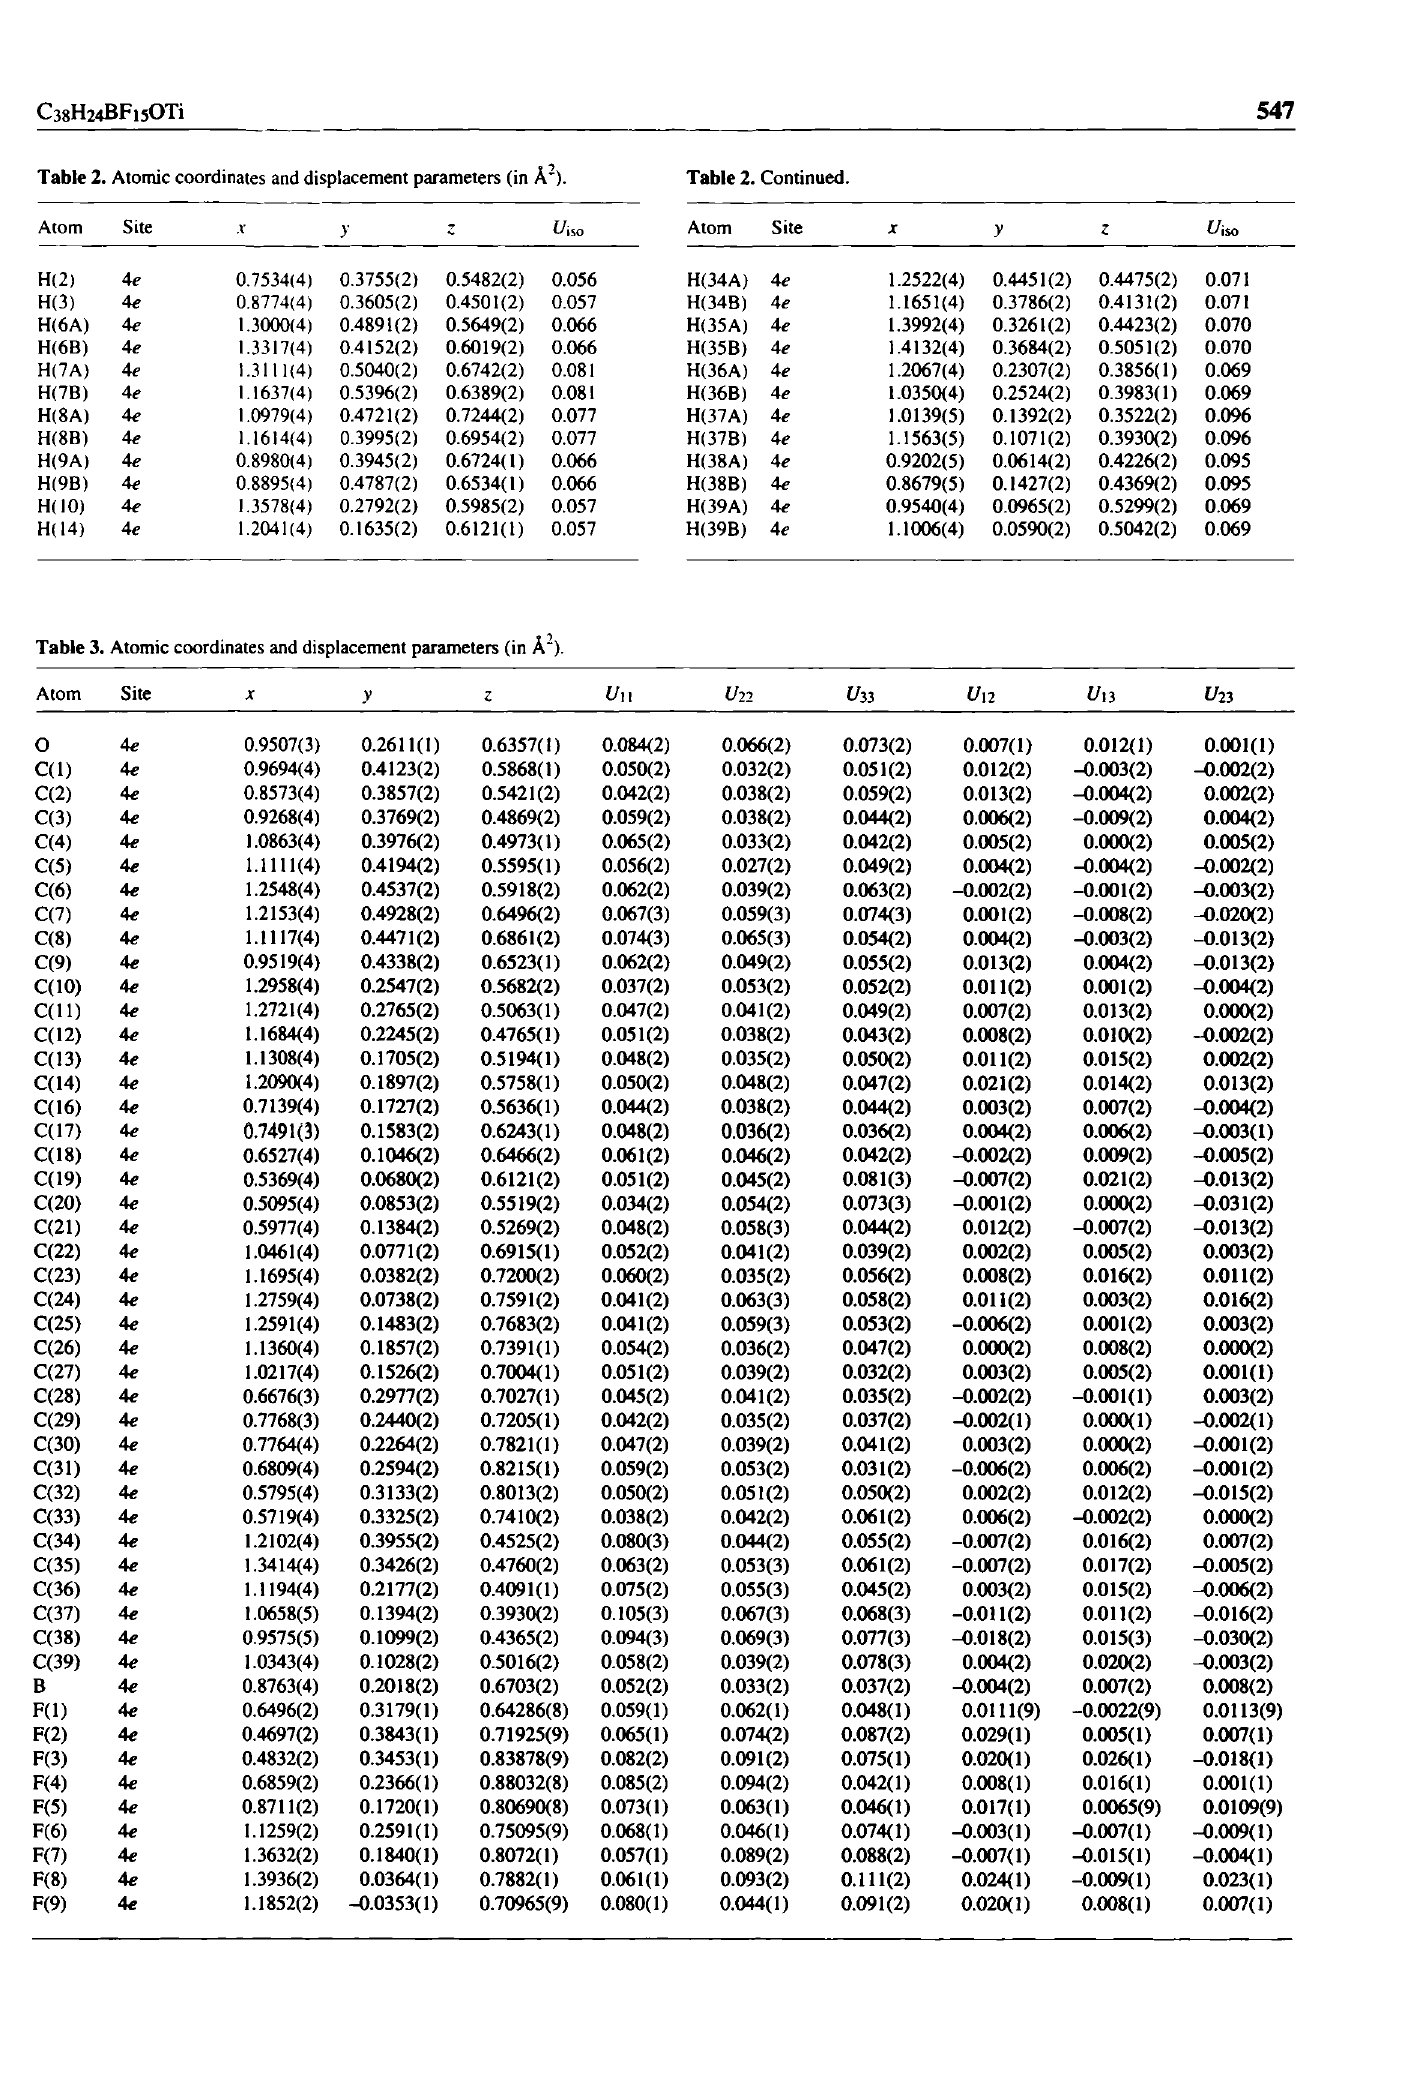
Table 3. Atomic coordinates and displacement parameters (in Â 2